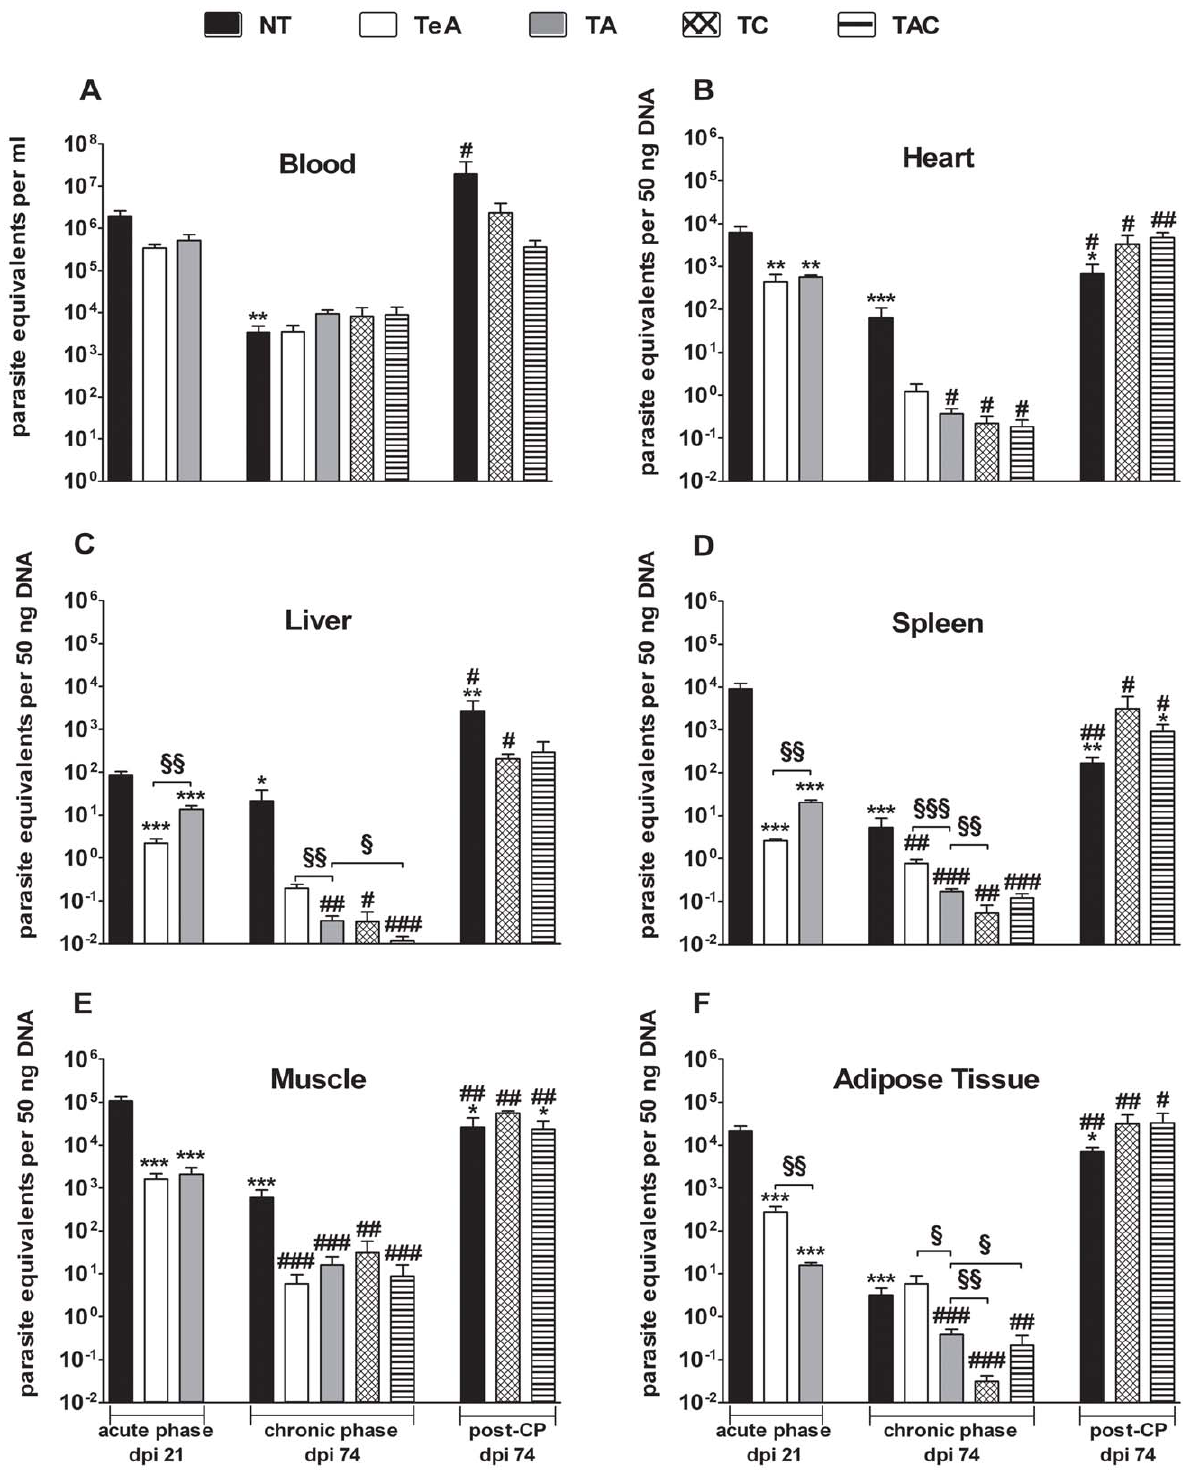
Figure 2. Tissue parasite amounts in AmBisome-treated mice. NT: untreated mice; AmBisome was administred either in early acute phase (TeA), in acute phase (TA), or in chronic phase (TC). TAC mice treated by AmBisome during the acute and the chronic phases of infection. Organs were collected either in acute phase (dpi 21) or in chronic phase (dpi 74) from mice having received or not cyclophosphamide (CP). Both TcZ and GAPDH sequences were quantified individually for each DNA sample. The amounts of parasite DNA in samples were expressed in parasite equivalents per mL of blood (A) or per 50 ng DNA for heart (B), liver (C), spleen (D), muscle (E) and adipose tissue (F). * denotes a significant difference with NT acute mice group, # denotes a significant difference with NT chronic mice group, 1 denotes a significant difference between treatments, *, # , 1 P , 0.05; **, ## , 11 P , 0.01; ***, ### , 111 P , 0.001.